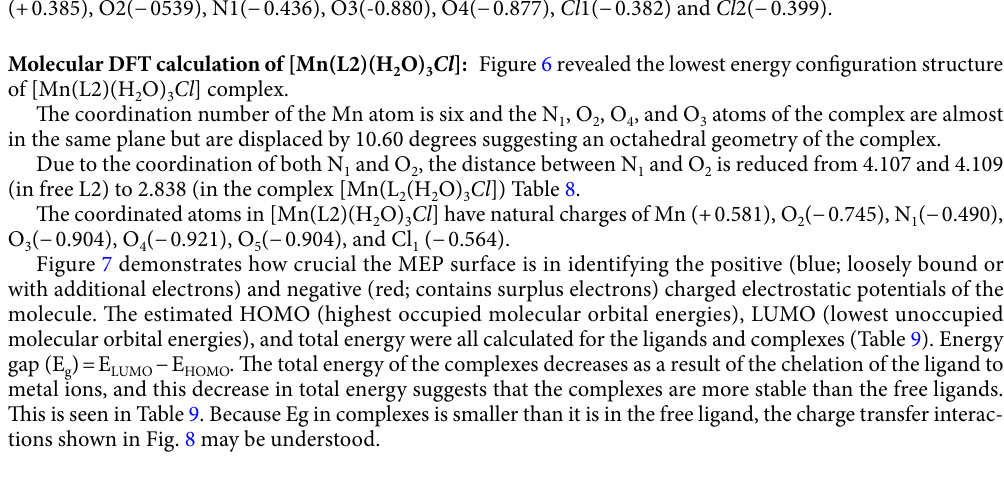
Table 7. The distance between N 1 and O 2 is decreased from 4.107 Å and 4.109 Å (in free L 1 and L 2 ) to 2.787 Å and 2.764 Å (in the complexes [Cr(L1)(H